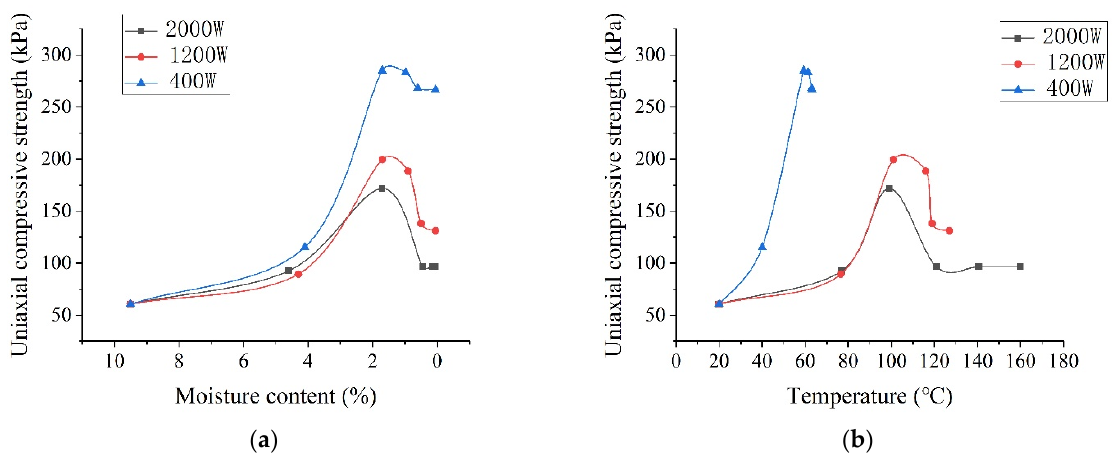
Figure 3. ( a , b ) The variations of uniaxial compressive strength versus temperature and moisture content, respectively.